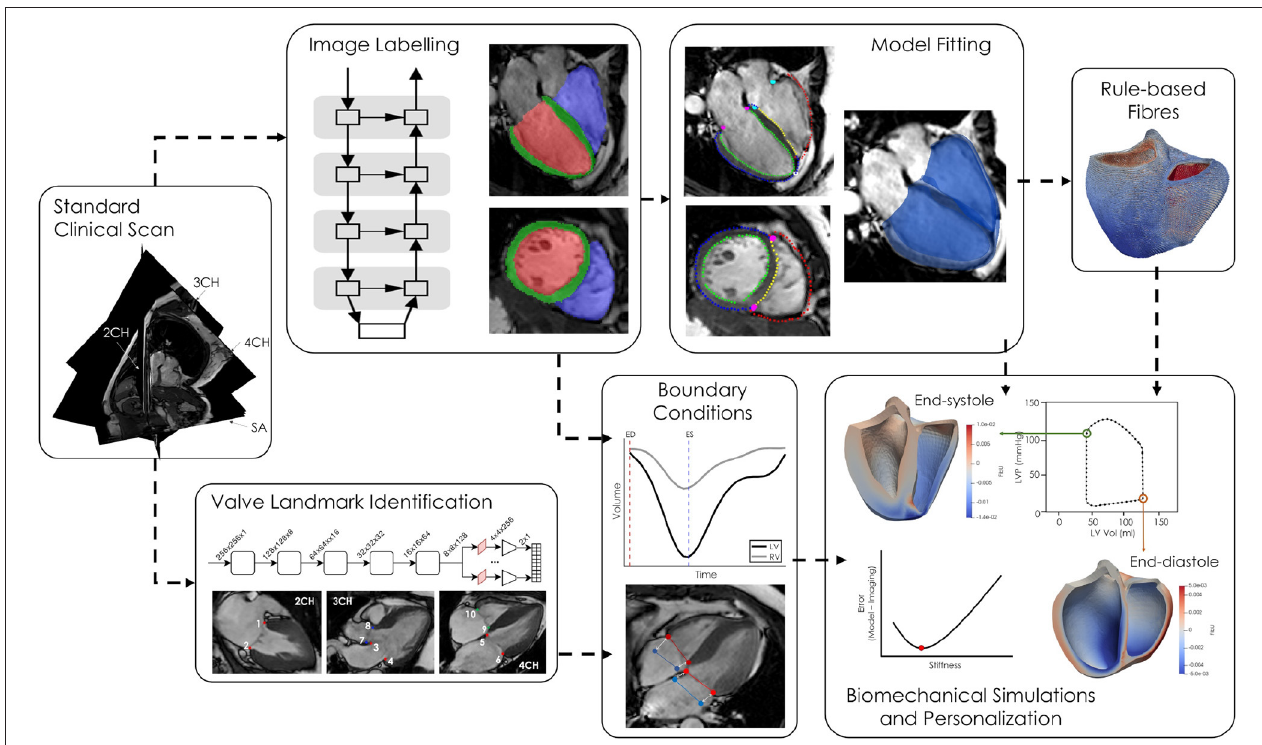
FIGURE 3 | Short and long-axis cine MR images are simultaneously fed into two neural networks, one for labelling the LV blood pool (red), LV myocardium (green), and RV blood pool (blue) and the second labelling ten valve landmarks throughout the cardiac cycle. The segmentations are converted to labelled contours and a biventricular template surface mesh is fitted to the labelled contours. Volumes, derived from the network generated cavity labels, as well as valve annuli motion are used as boundary conditions in the biomechanical simulations. Passive parameters are optimised by minimising the difference between the model and imaged geometries at